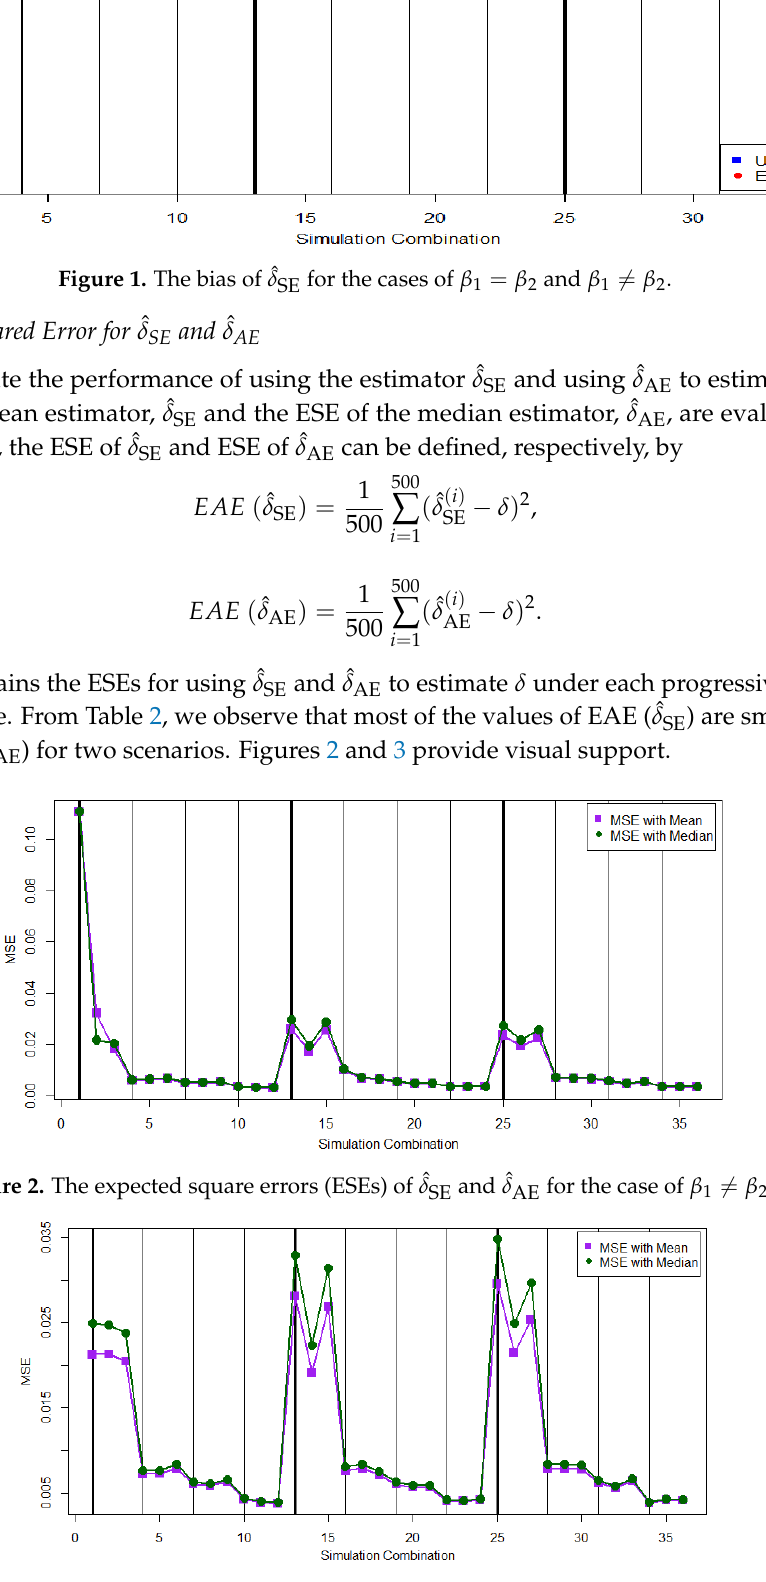
Figure 3. The ESEs of ˆ δ SE and ˆ δ AE for the case of β 1 = β 2